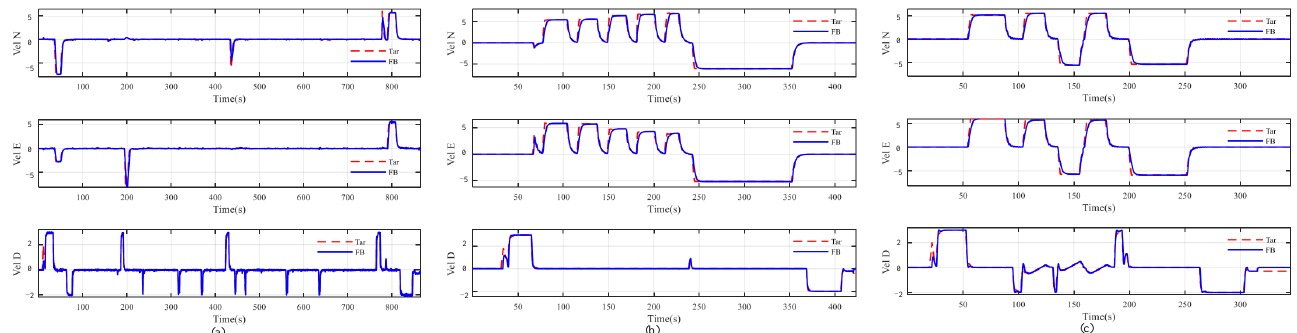
Figure 12. ( a ) Speed-tracking results for fine inspection; ( b ) Speed-tracking results for chasing